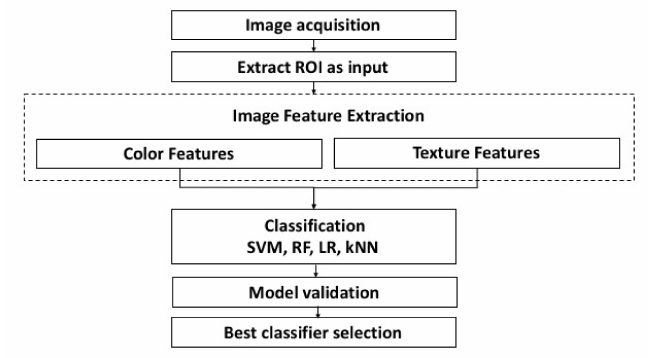
Figure 2. Flowchart of proposed fish classification methodology.